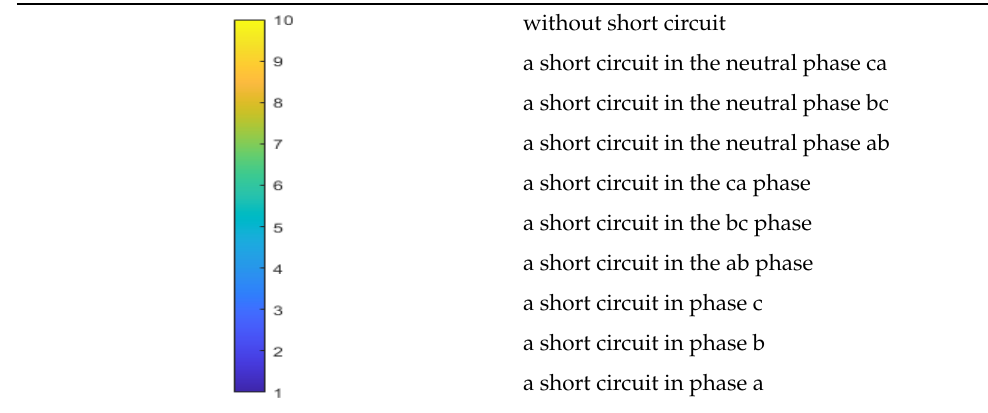
Table 1. Color assignments of the characteristics shown in Figures 9–16.